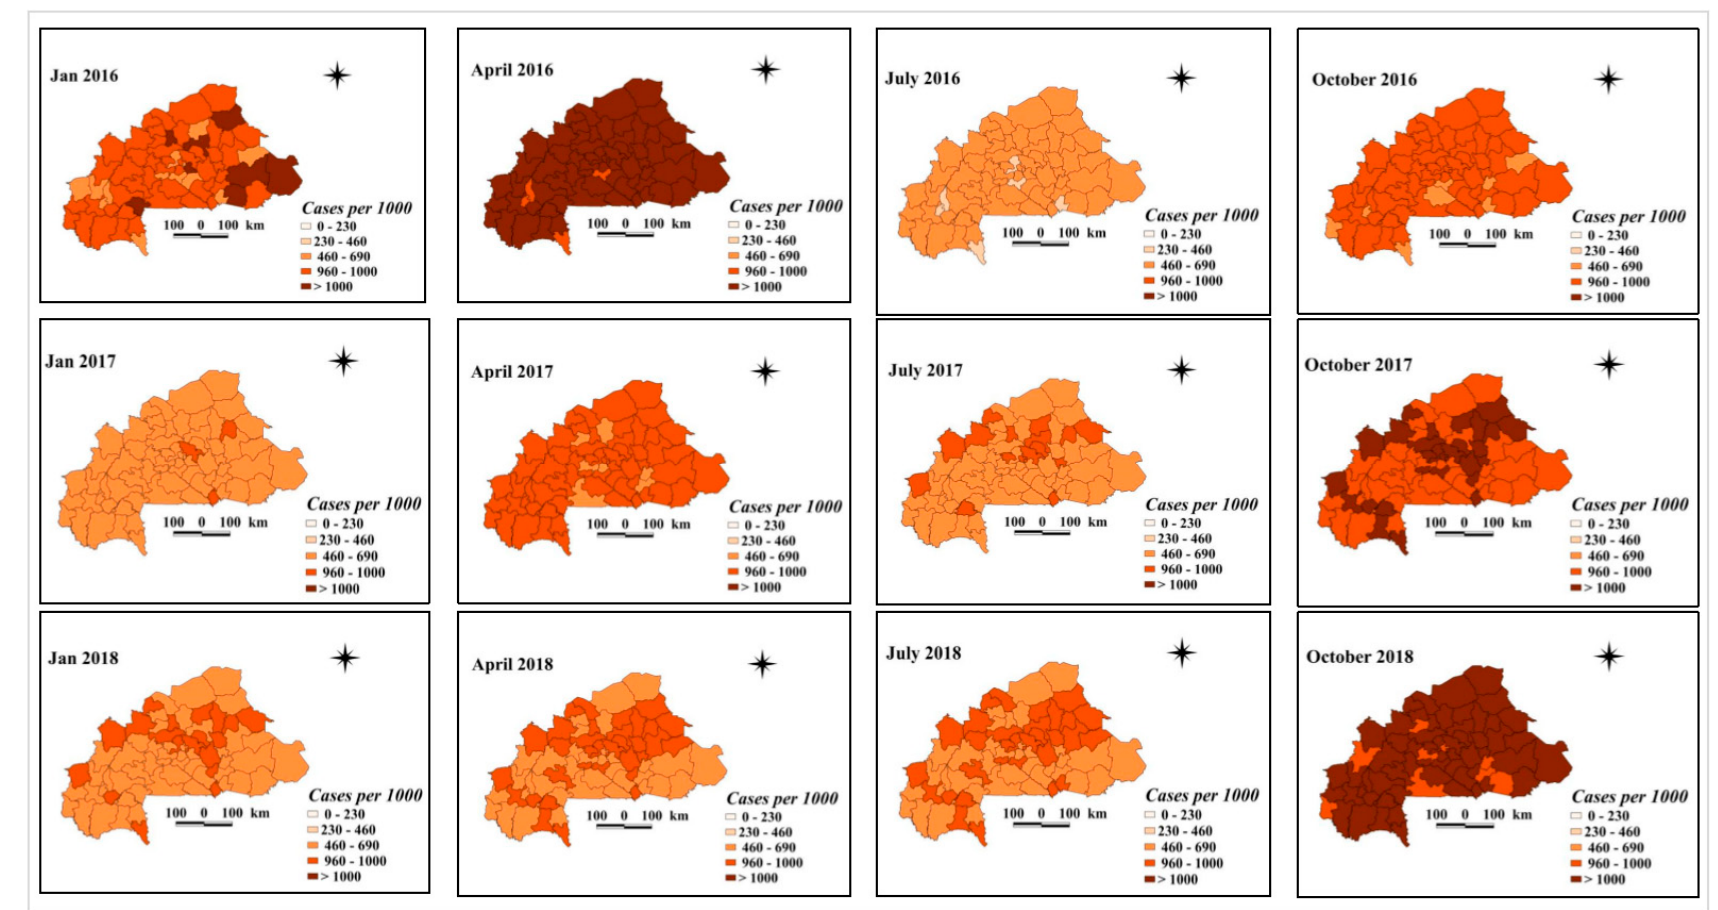
Figure 5. Space–time patterns of confirmed malaria rate (confirmed cases per 1000 total cases) in children less than 5 years estimated from the Bayesian spatio-temporal model.